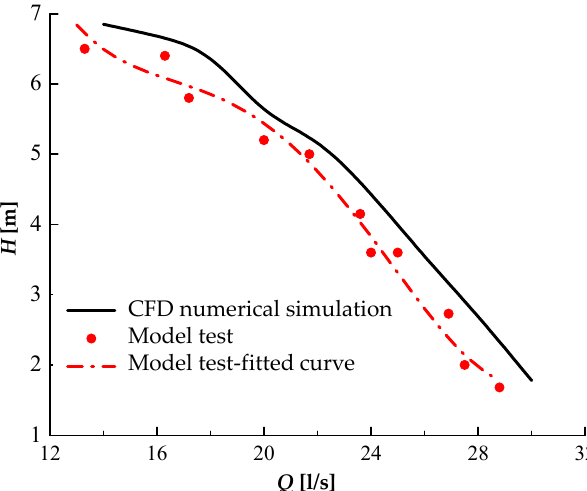
Figure 5. Comparisons of numerical simulation and model test results at v = 2 m /